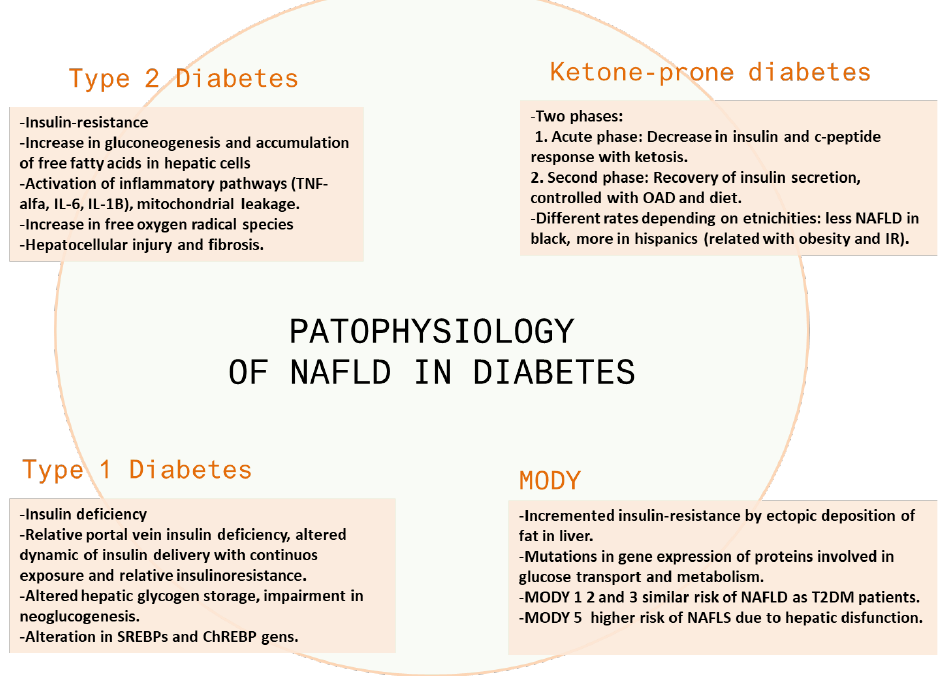
Figure 1. Main mechanisms involved in the physiopathology of NAFLD in different types of diabetes. OAD: oral antidiabetic drugs